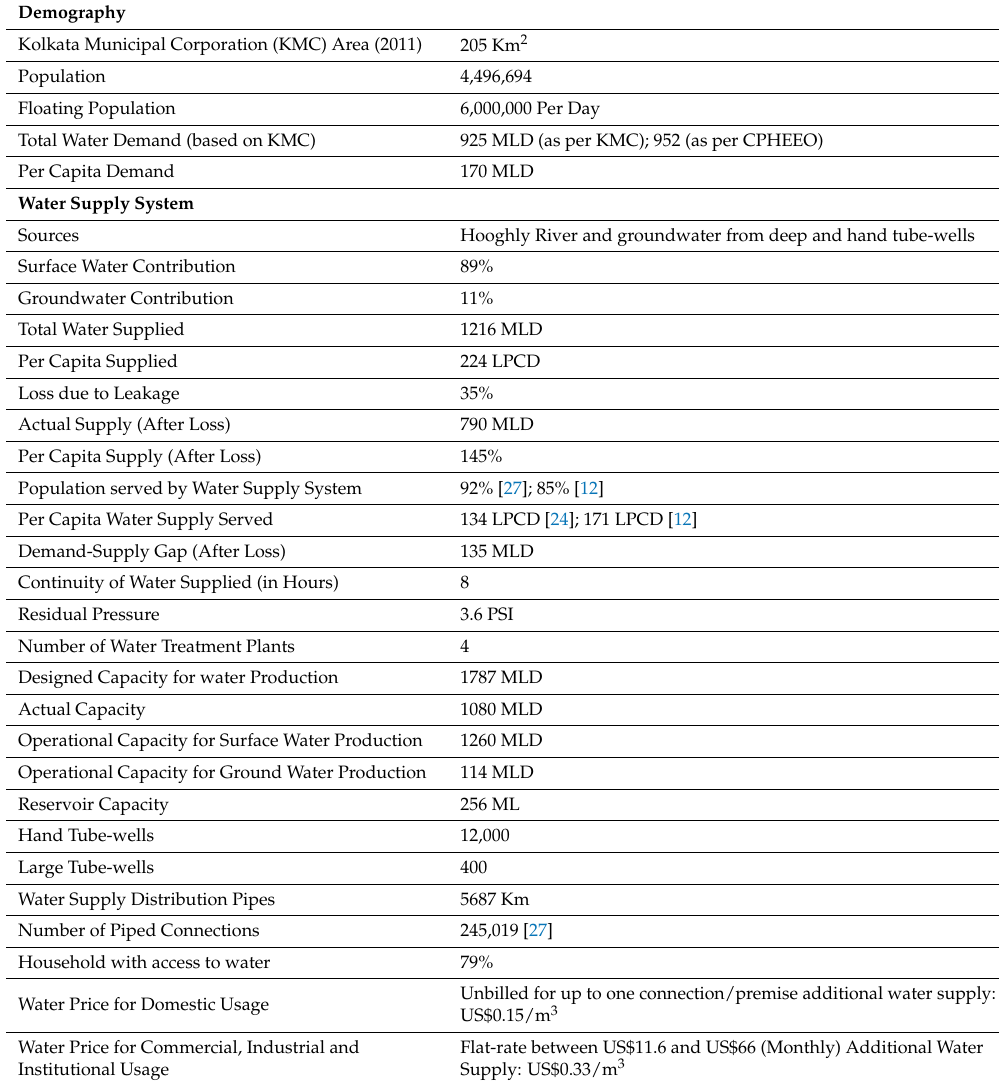
Table 2. Water Statistics of Kolkata Municipal Corporation (KMC)